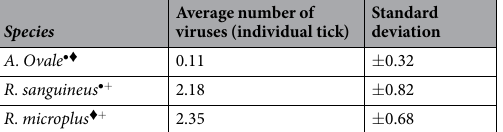
Table 2. Viral richness by tick species. • Pairwise comparison of A. ovale and R. sanguineus : p = 1.82 × 10 − 14 . ♦ Pairwise comparison of A. ovale and R. microplus : p = 1.55 × 10 − 14 . + Pairwise comparison of R. sanguineus and R. microplus : p = 8.24 × 10 − 5